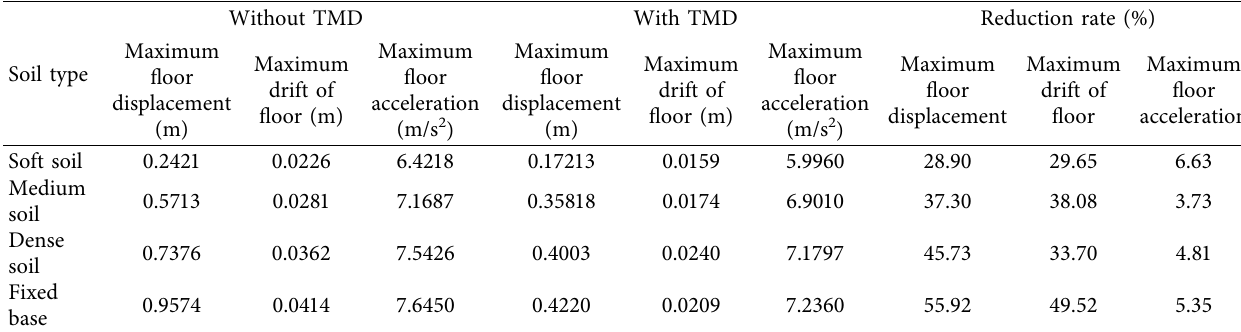
Table 7: Dynamic response to Tangshan wave with or without